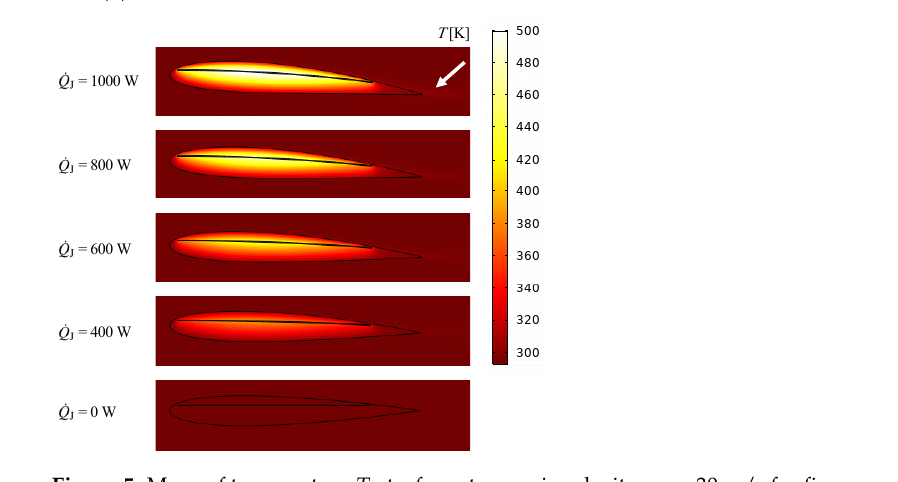
Figure 5. Maps of temperature T at a free-stream air velocity v 0 = 30 m/s for five cases of power feed ˙ Q J , from 0 to 1000 W, with indication of the thermal discharge past the trailing edge of the